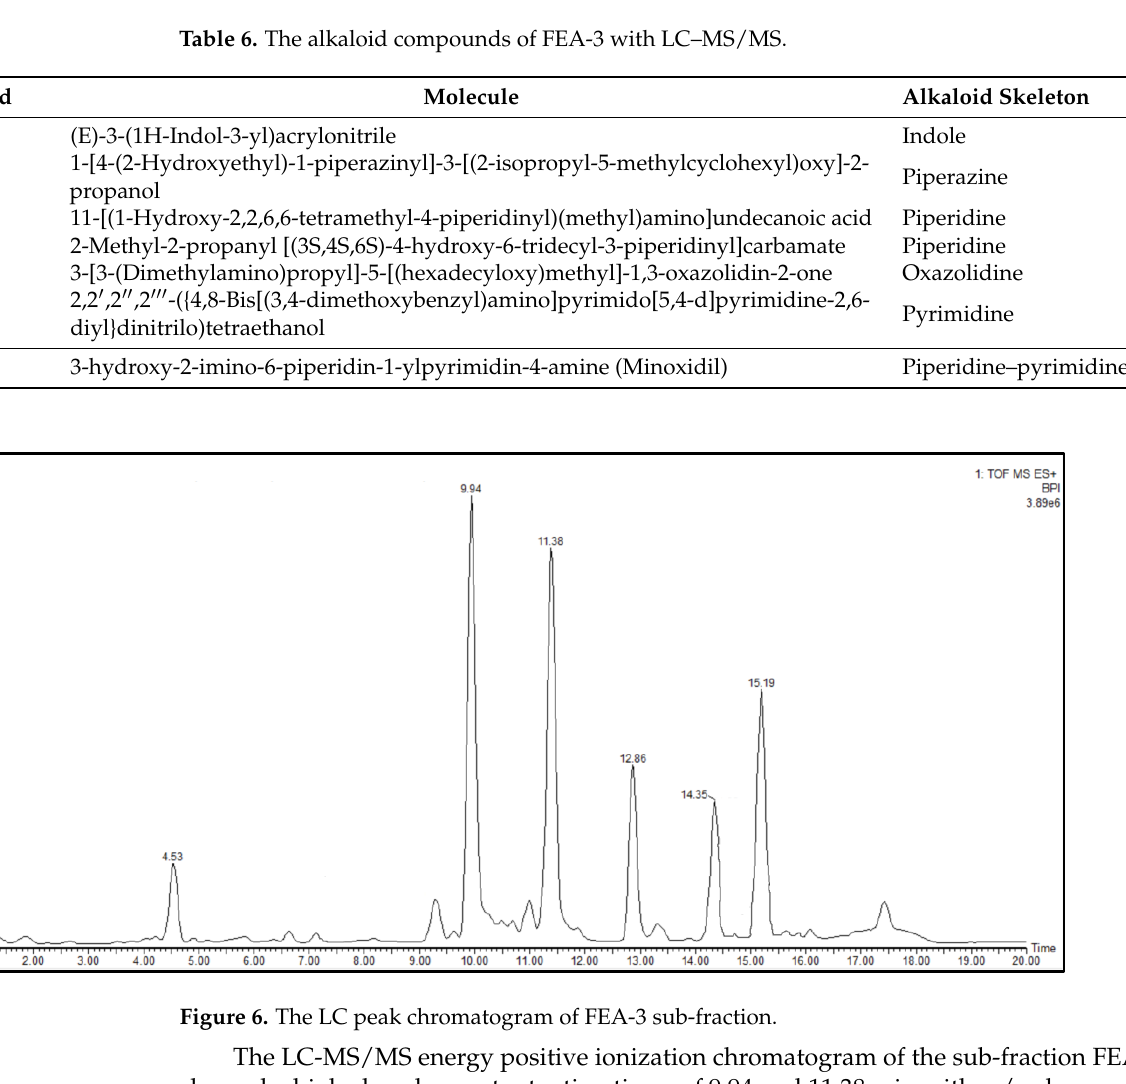
Table 5. The LC-MS/MS profile of FEA-3 sub-fraction. Compound RT (Min) Formula Observed m / z Abundance